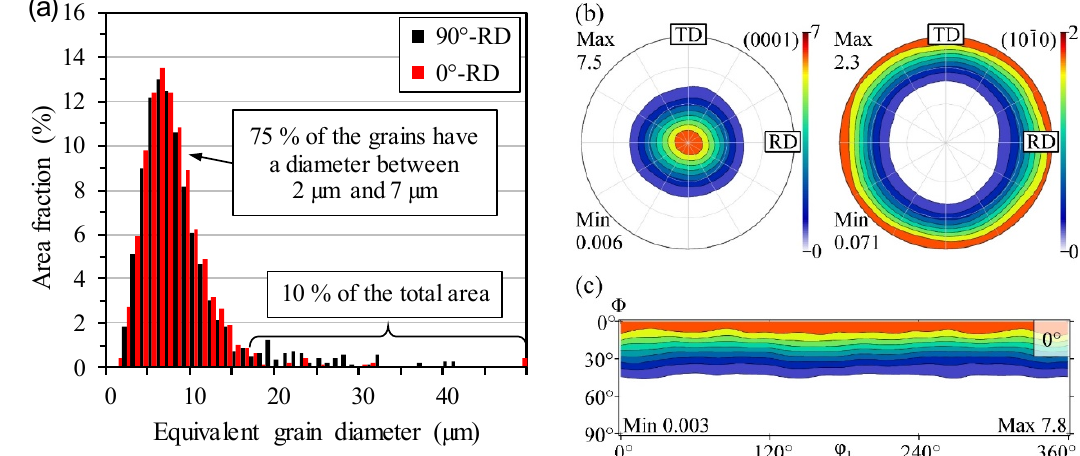
Figure 3. The initial microstructure of the AZ31 magnesium sheet studied, characterized by ( a ) the grain size distribution with reference to the respective area fraction, ( b ) pole figures with reference to the basal and prismatic planes, as well as ( c ) the orientation distribution function (ODF) section at ϕ 2 = 0 ◦.